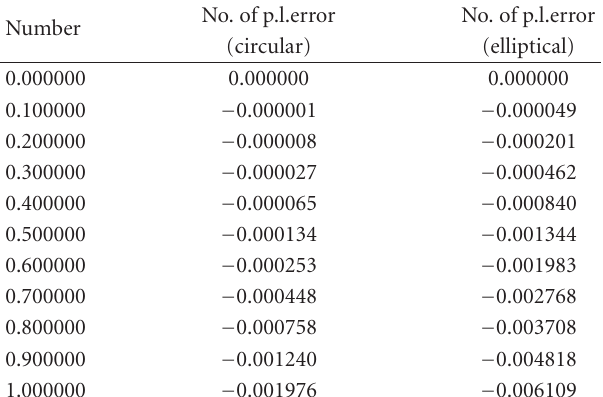
Table 1: Comparison of phase